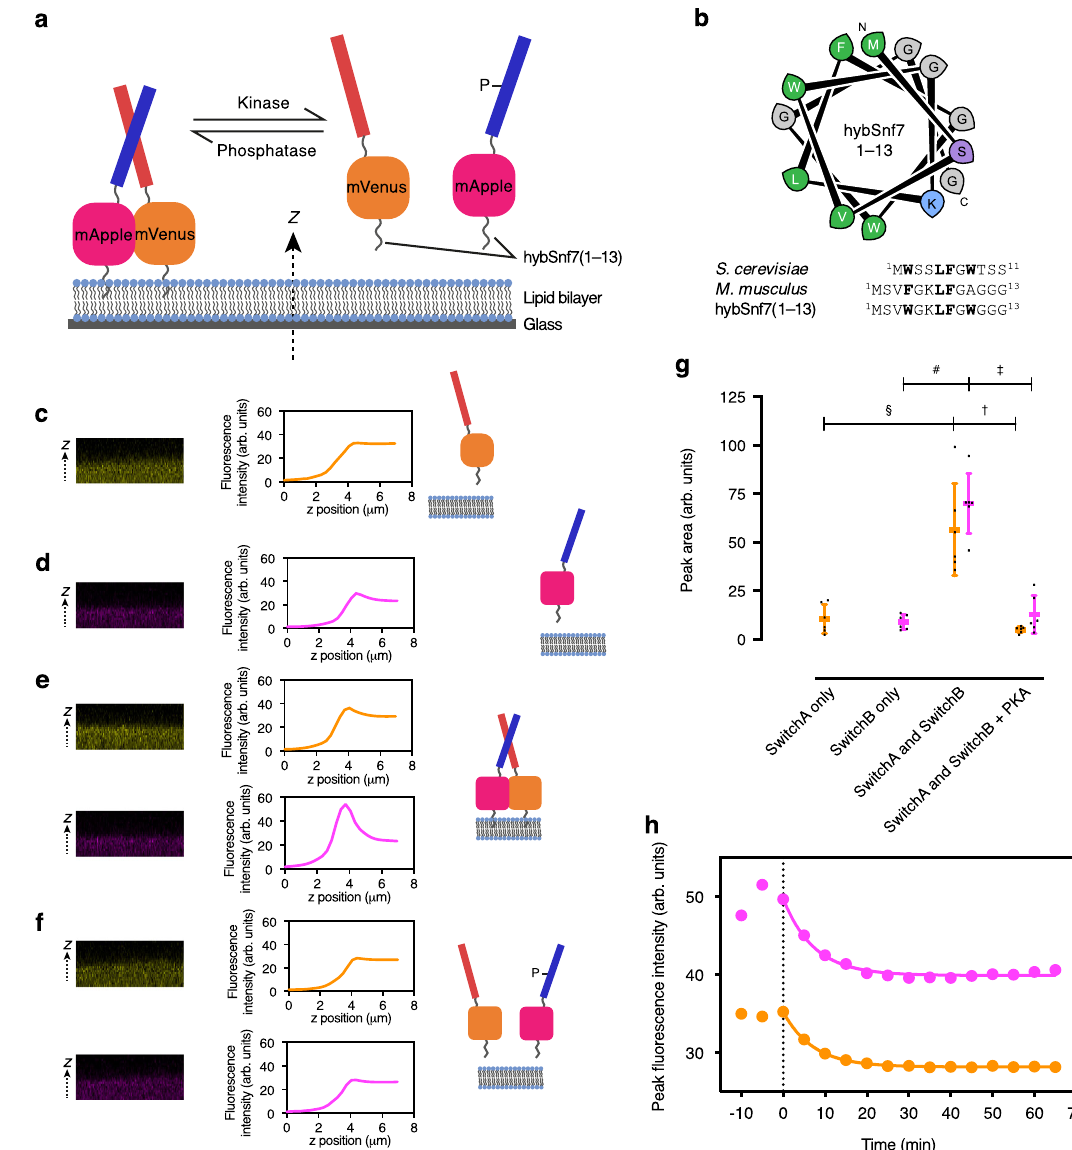
Fig. 4 Oligomeric switching of membrane-binding state. a Schematic illustrating design and concept of switching with CC-Di-A_S colored red and CC-Di- B_RRS blue. b Helical wheel diagram of hybSnf(1 – 13) and alignment of S. cerevisiae , M. musculus , and hybrid Snf7 sequences with conserved hydrophobic residues highlighted in bold. c – f Representative orthogonal views of the xz plane of confocal microscopy image z-stacks with fl uorescence intensity z- pro fi les and illustrative schematics for SLBs with: c 1 µ M SwitchA only, d 1 µ M SwitchB only; e 1 µ M each of SwitchA and SwitchB; and f 1 µ M each of SwitchA and SwitchB 1 h after MgATP and PKA were added. g Quantitation of membrane binding of SwitchA (orange) and SwitchB (pink) under the conditions of panels c – f calculated from fl uorescence z-pro fi les ( n = 6 independent experiments; error bars represent mean ± S.D.; § p = 0.0011, t = 4.5167; # p < 0.0001, t = 9.4307; † p = 0.0003, t = 5.3073; ‡ p < 0.0001, t = 7.7144; unpaired two-tailed t test). h Representative kinetics of phosphorylation- induced release of SwitchA and SwitchB from the SLB after the addition of MgATP and PKA at t = 0. Plotted fl uorescence intensities (arbitrary units) are peak intensities (i.e., membrane localized), determined from z-axis fl uorescence intensity pro fi les such as those shown in c – f . Values were fi tted with the function y ¼ y 0 þ ð y 1 (cid:2) y 0 Þð 1 (cid:2) e (cid:2) kx Þ . SLBs were DOPC with 0.1 mol% ATTO655-DOPE. The SLB buffer was 50 mM Tris.HCl, pH 7.5, 300 mM KCl, and 5 mM MgCl 2 . Six experimental replicates were